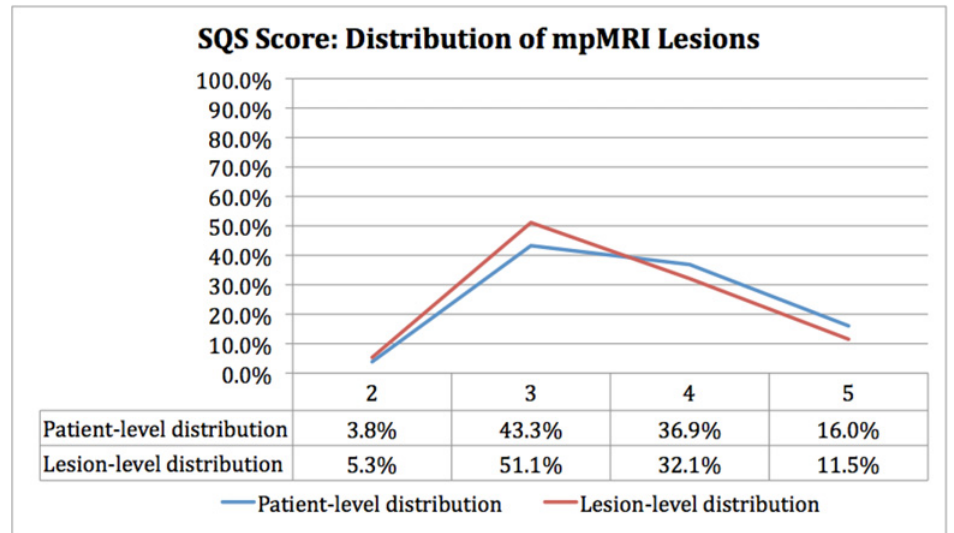
Fig 8. Distribution of lesions reported on mpMRI stratified by SQS Score.